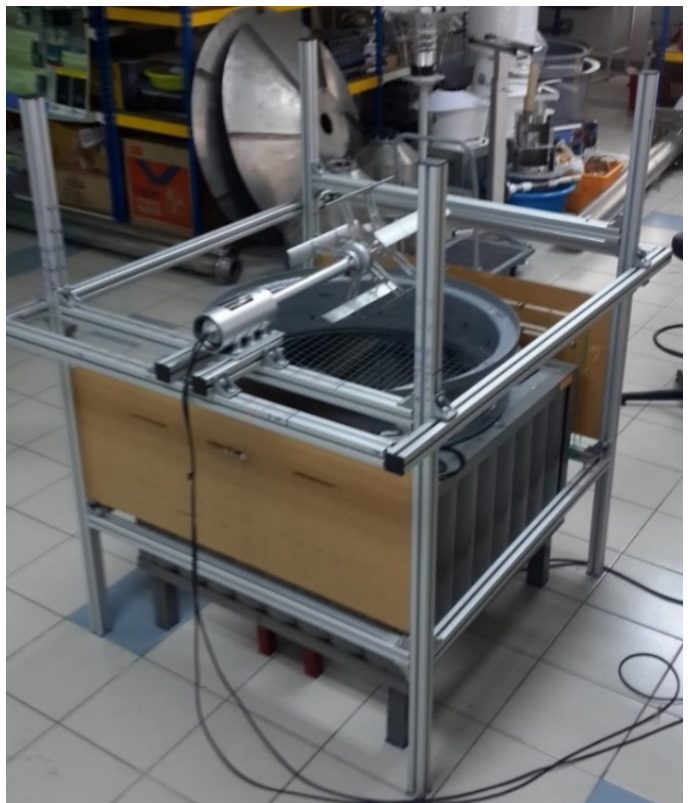
Figure 4. Test rig, consisting of cooling tower model, wind turbine, generator, and supporting frame.